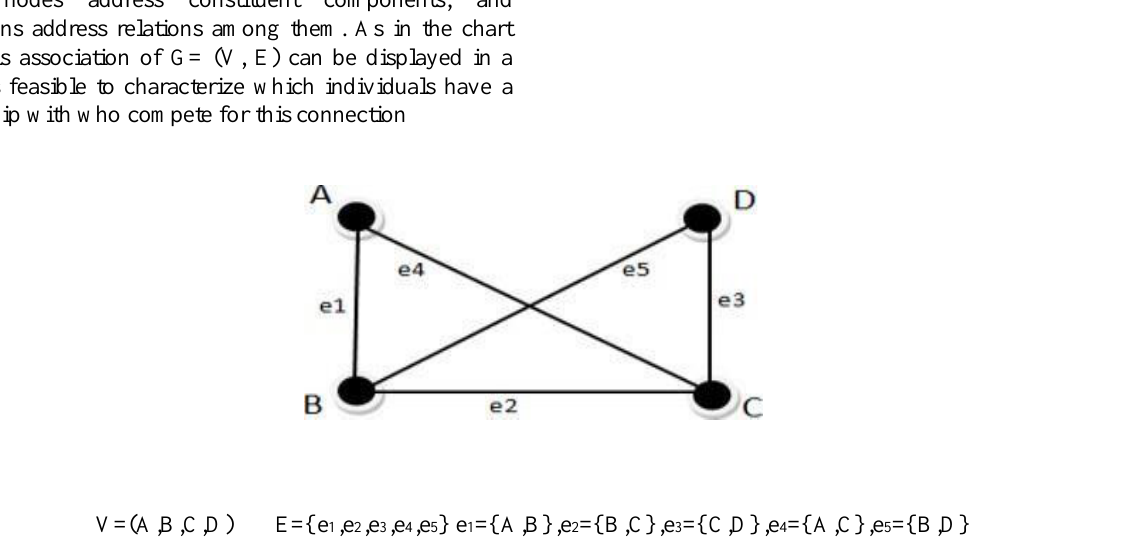
Figure 3. Meaning of nodes and connection between them. (A,B,C,D) and (e1,e2,e3,e4,e5) are nodes and connections,